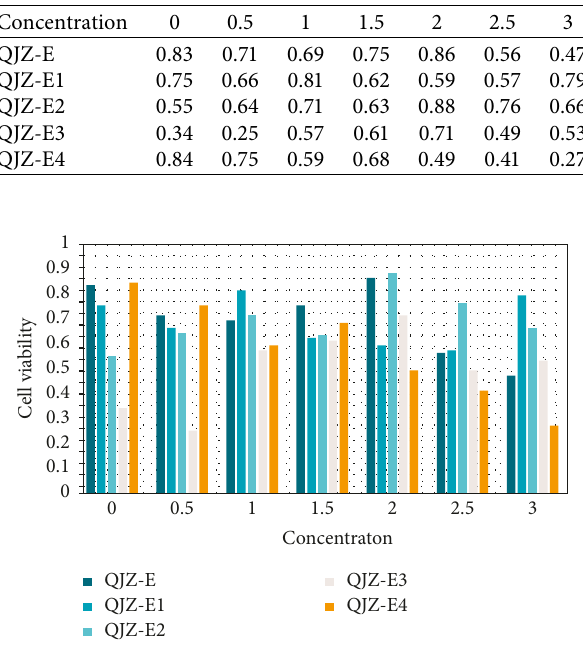
Figure 1: Cell survival